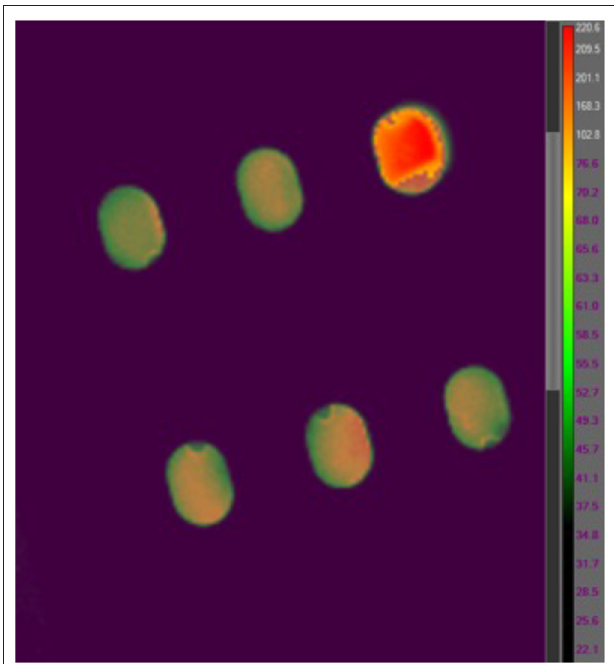
FIGURE 2 | An example coupon IR heating image from the FLIR T650sc IR camera viewed in FLIR ResearchIR 14. The coupon measured is located in the upper-right corner of the image. The other five coupon slots are out of focus, and the temperatures are not